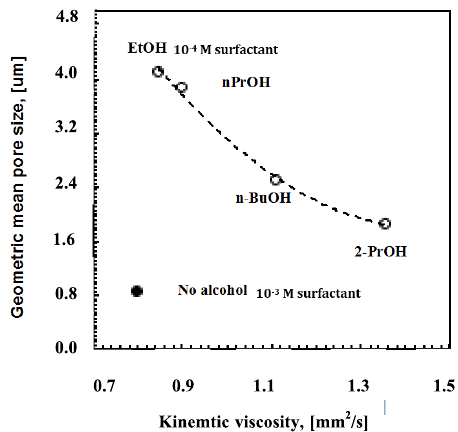
Figure 7. Geometric pore size vs. kinematic viscosity for solutions (o) containing surfactant at 10 −4 M and alcohols with different length and bulky chains.